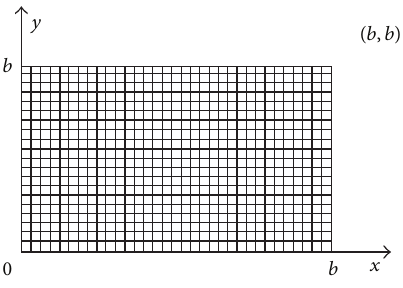
Figure 1: Rectangular membrane of 𝑏 × 𝑏 length.